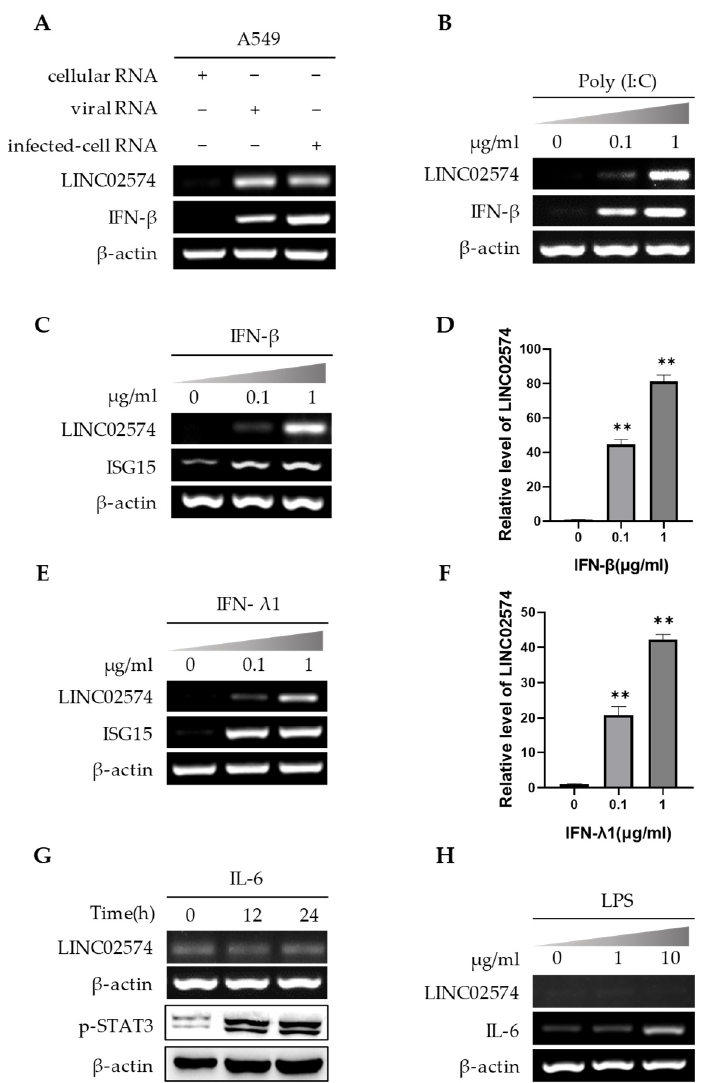
Figure 3. LINC02574 is an IFN-stimulated gene. ( A ) Cellular RNA (total RNA from uninfected control A549 cells), viral RNA, and infected-cell RNA (total RNA from A549 cell infected with PR8 virus) were transfected into A549 cells for 24 h. RT-PCR was performed to examine the expression level of LINC02574. ( B ) A549 cells were transfected with poly(I:C) at the indicated concentrations for 18 h. The expression levels of LINC02574 were examined by RT-PCR. ( C – F ) A549 cells were treated with IFN- β ( C , D ) or IFN- λ 1 ( E , F ) at indicated concentrations for 12 h, and the expression of LINC02574 was examined by RT-PCR ( C , E ) and qRT-PCR ( D , F ). ( G ) A549 cells were treated with IL-6 (0.1 μ g/mL) for the indicated times. The expression of LINC02574 was detected by RT-PCR and the phosphorylation level of STAT3 was examined by Western blotting. ( H ) A549 cells were incubated with LPS at the indicated concentrations for 12 h. The expression of LINC02574 was determined by RT-PCR. Data are represented as mean ± SD; n = 3; One-way analysis of variance (ANOVA) followed by LSD test: ** p < 0.01 versus 0 μ g/mL.